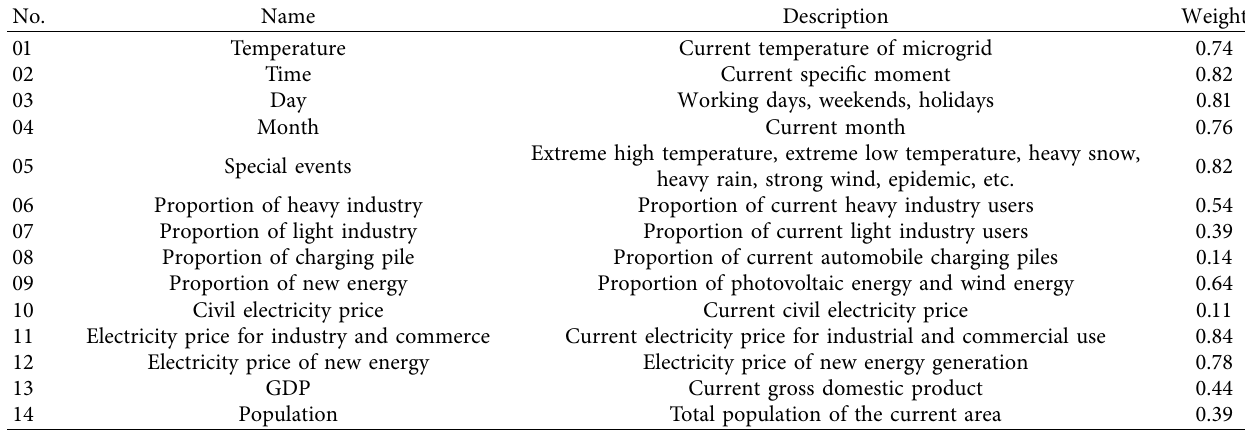
Table 1: Analysis of influencing